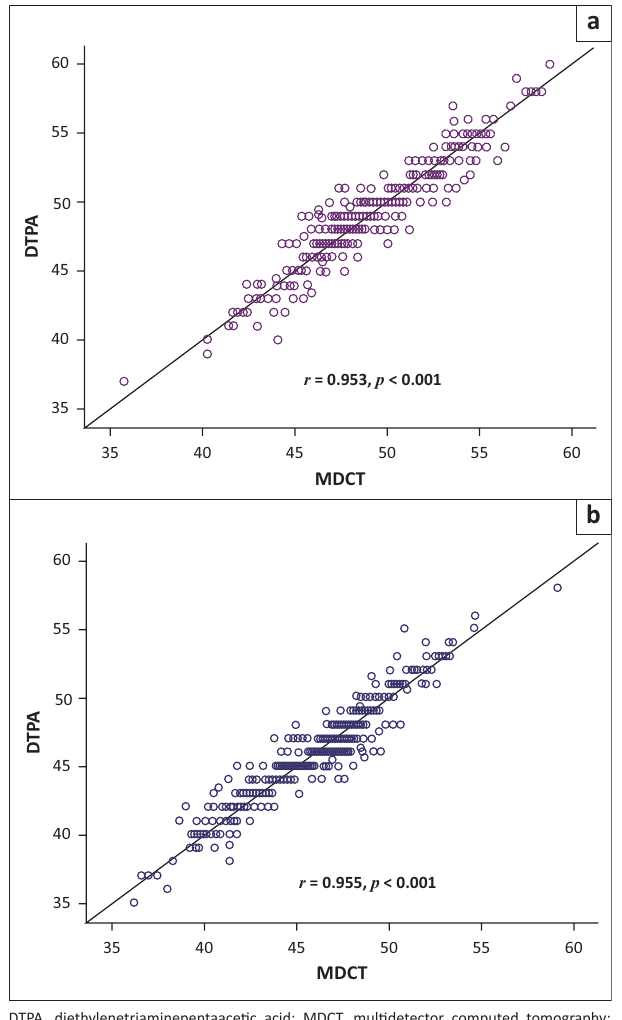
FIGURE 2: Scatter diagram showing a strong linear relationship between diethylenetriaminepentaacetic acid and multidetector computed tomography measurements: (a) left kidney and (b) right kidney.